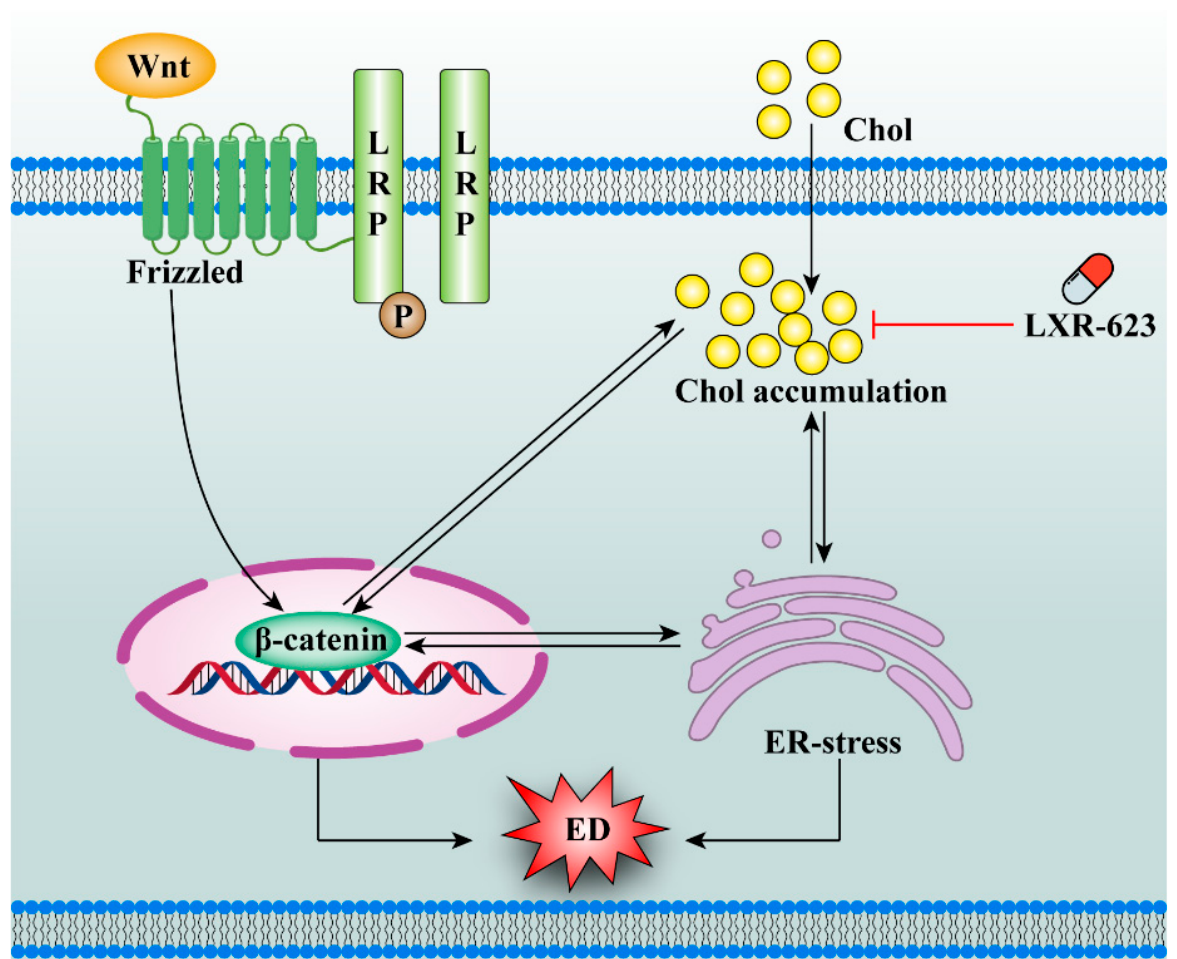
Figure 9. The possible relationship between ER stress, cholesterol metabolism, and the Wnt/ β -catenin pathway.